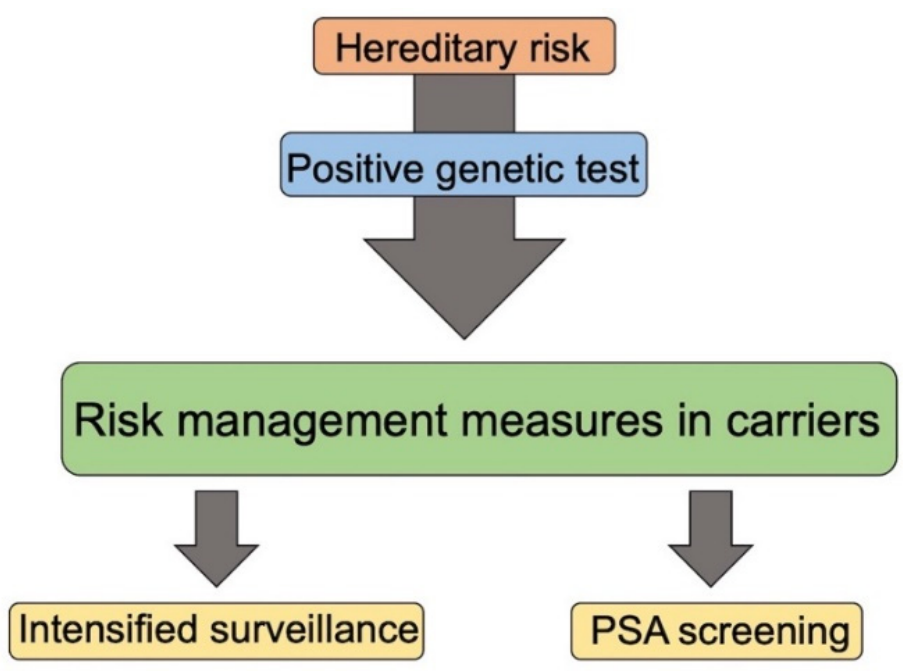
Figure 3. Management of unaffected family members with positive genetic